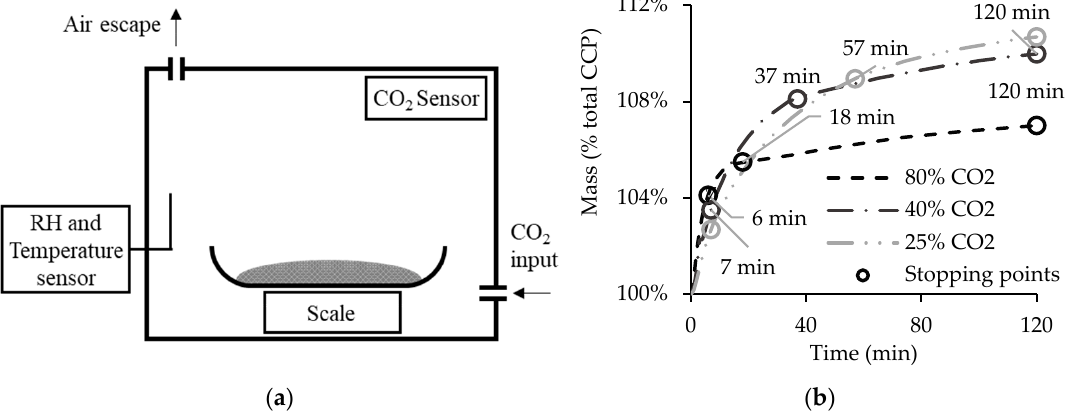
Figure 2. Equipment setup for the mass growth analysis ( a ) and the mass growth of CPP and stopping points considered during the carbonation process ( b ).